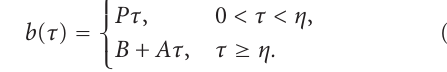
of packets arrives, it is allowed to pass if enough tokens have been accumulated in the token